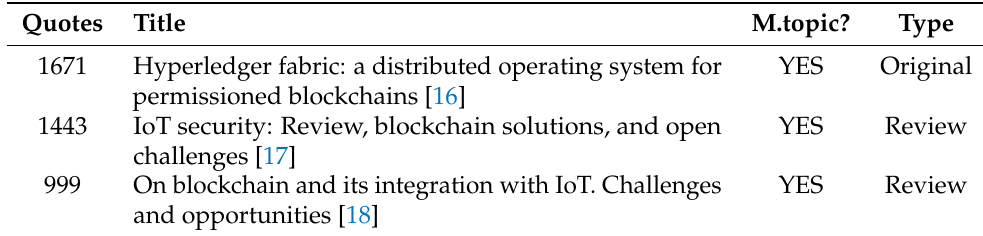
Table 5. Top 3 citations 2018.